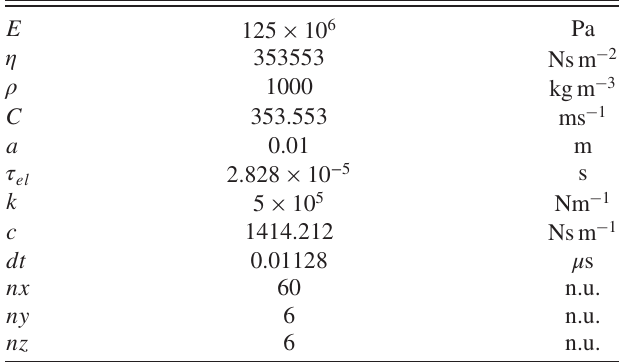
TABLE II. Parameters for MSM model used in Appendix D. n.u. stands for no